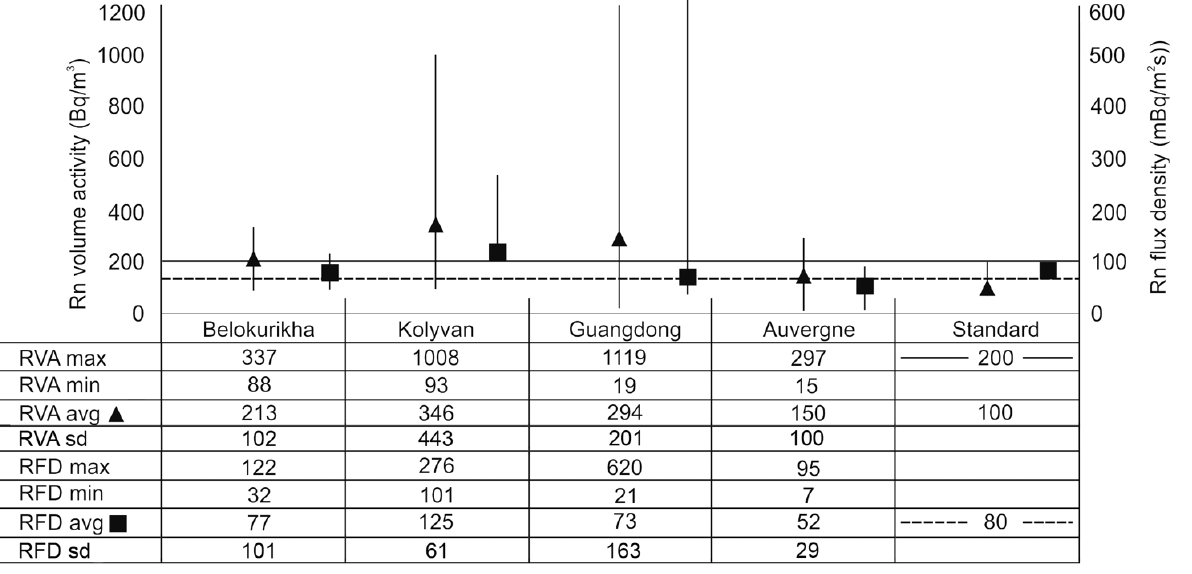
Figure 3. Graphic display and numerical data from measurements of RVA (Bq m − 3 ) and RFD (mBq (m 2 s) − 1 ) in the study regions. RVA standard according to Radiation Safety Standards (NRB-99) [33,35]; RFD standard according to Practical Guidance 11-102-97 [80]. Avg, average; sd, standard